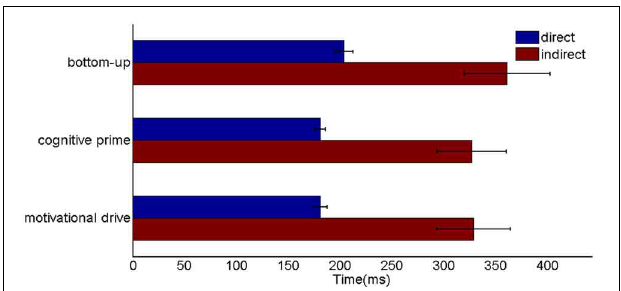
FIGURE 15 | Search reaction times under different search conditions. The search reaction times are statistically computed in the eye movement map via bottom-up, cognitive primed, and motivational drive search mechanisms through a direct and an indirect route. Blue bars correspond to the direct route and red bars indicate the indirect route. The slowest RTs are in the bottom-up pathway via the indirect route (375 ± 50ms). The simulation reaction times of the cognitive primed pathway (335 ± 40ms) and motivational drive pathway via the indirect route (335 ± 45ms) are similar. The RTs via the direct route are: bottom-up pathway (200 ± 10ms), cognitive primed pathway (180 ± 5ms), and motivational drive pathway (180 ± 5ms), respectively. See the text for further